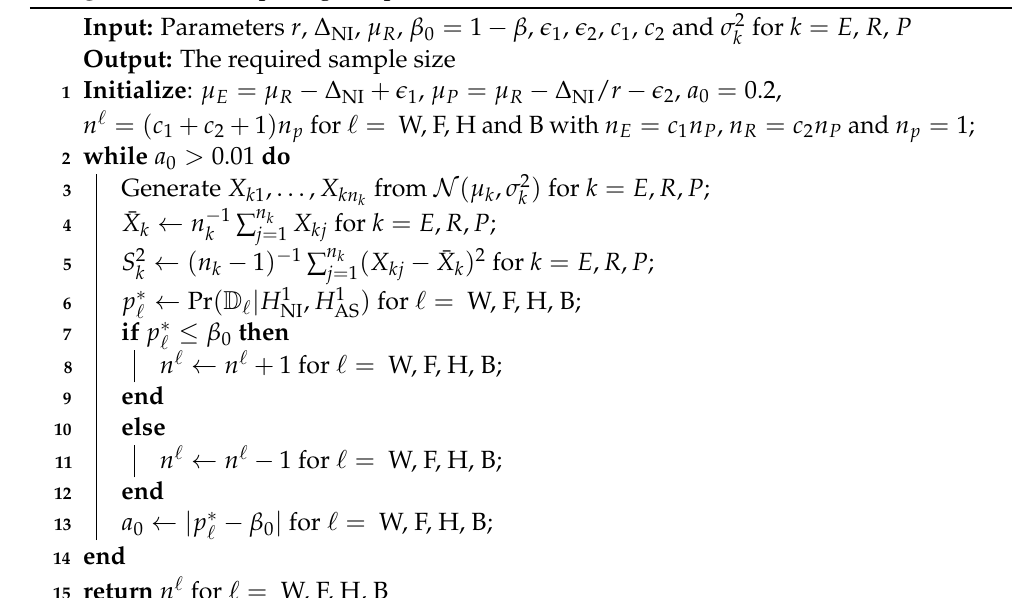
Algorithm 3: Computing sample